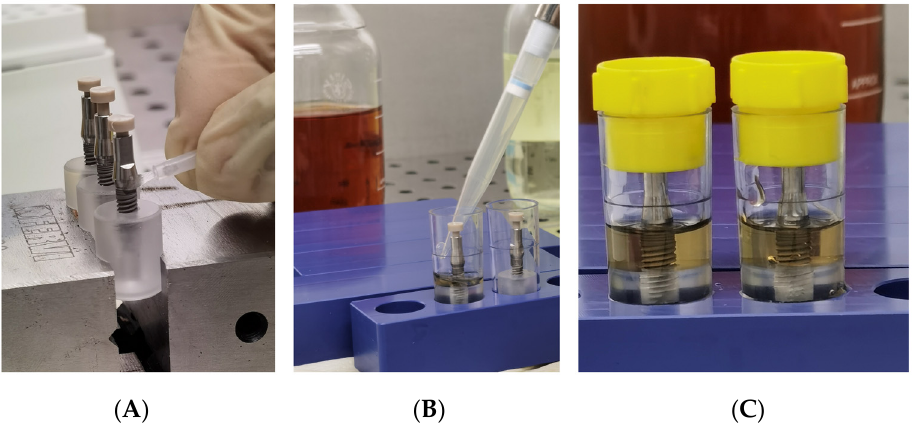
Figure 5. ( A ) Inoculation of a 3D printed peek cap in the upper hole of each abutment; ( B ) Placing of specimens in sterile tubes and nutrient solution; ( C ) Closure of tubes with cap.